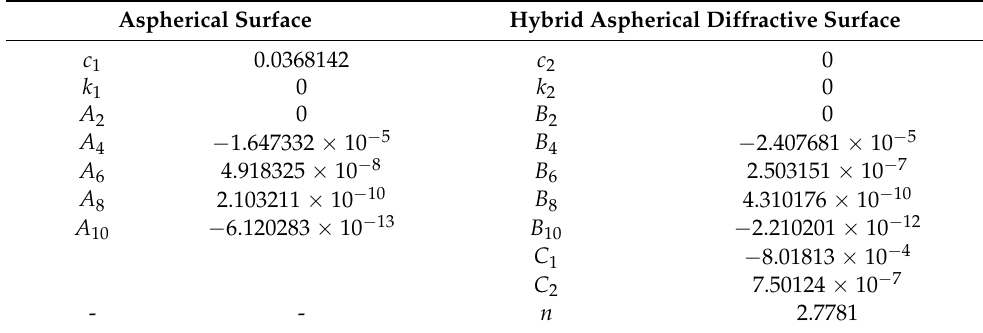
Table 1. The coefficients of the designed lens.